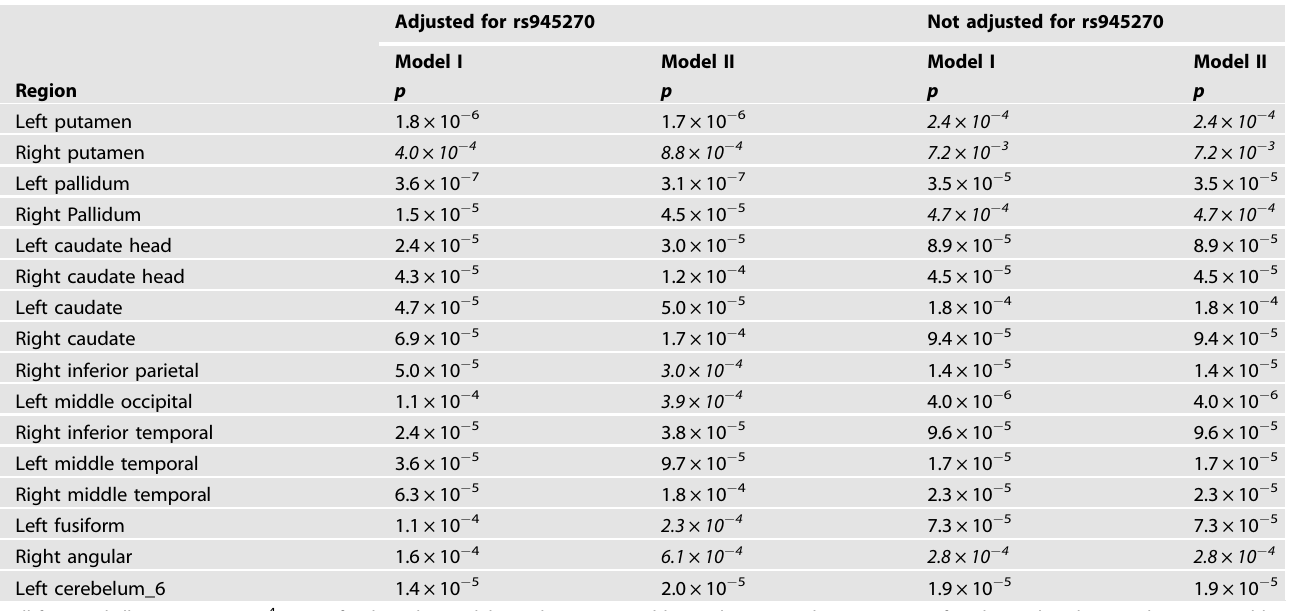
Table 3. Signi fi cant associations between GMVs and ADHD in